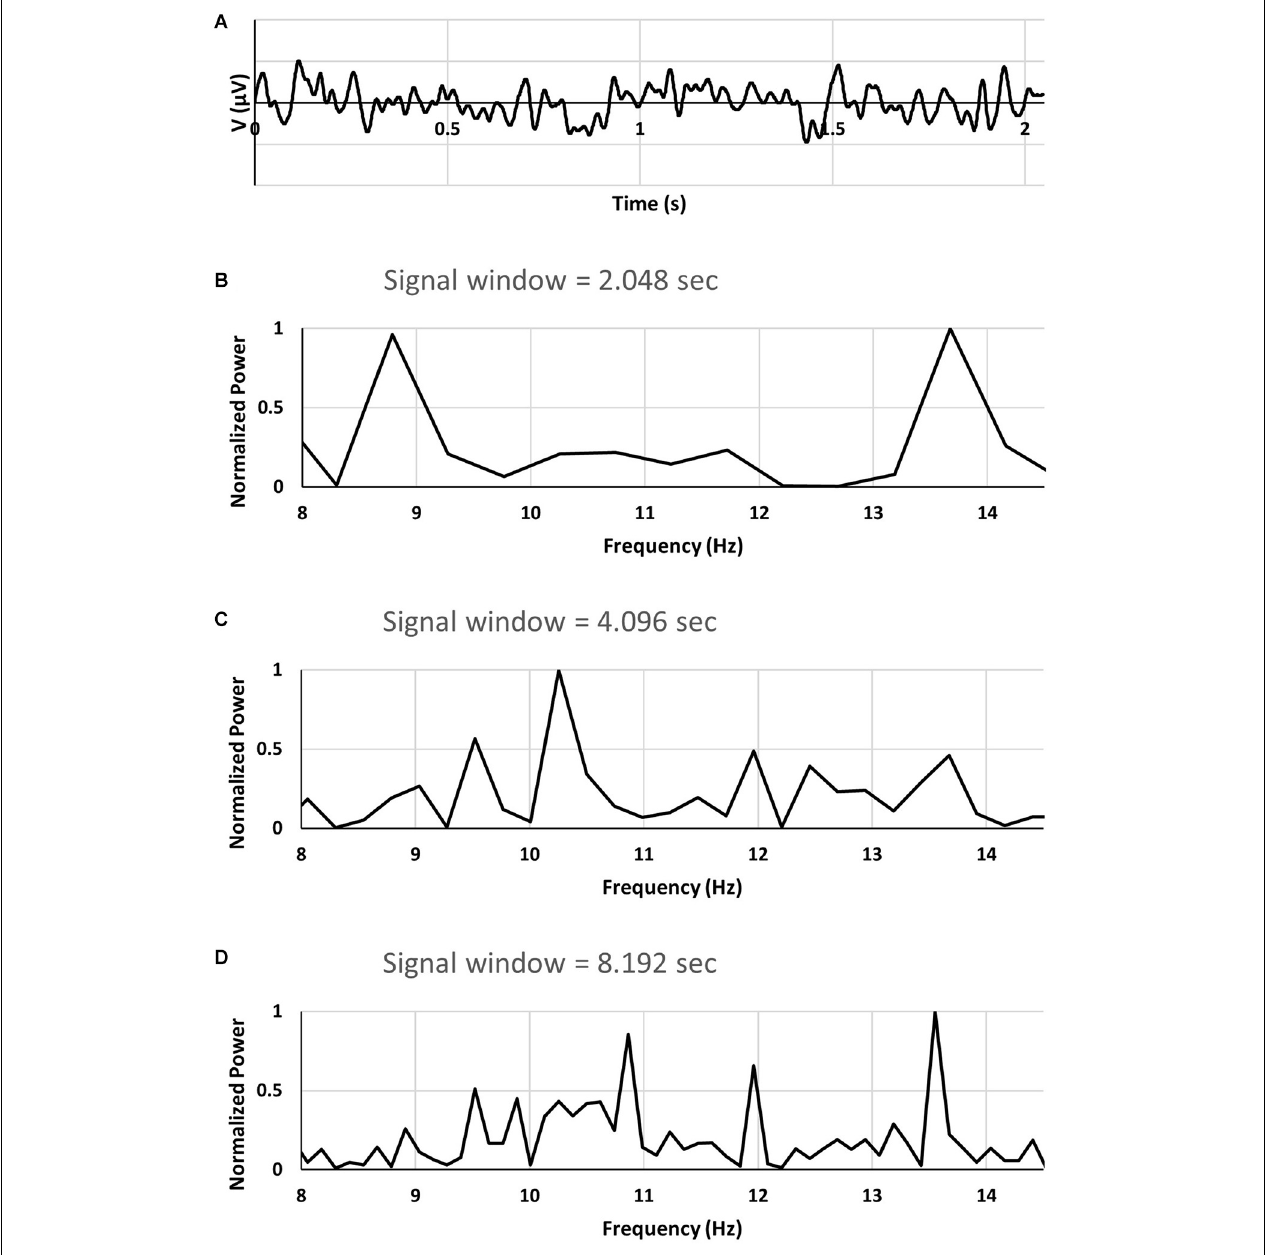
FIGURE 1 | (A) segment of EEG signal. (B–D) FFT power spectra of EEG signal using signal windows of 2.048, 4.096, and 8.192 s. See text for a